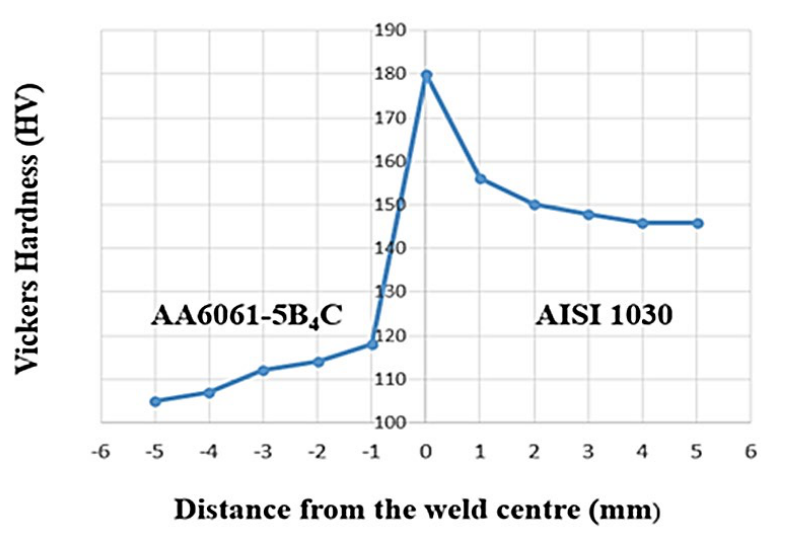
Figure 7. Microhardness distribution of AA6061-5%B 4 C/AISI 1030 friction welded joint processed in an inert atmosphere.